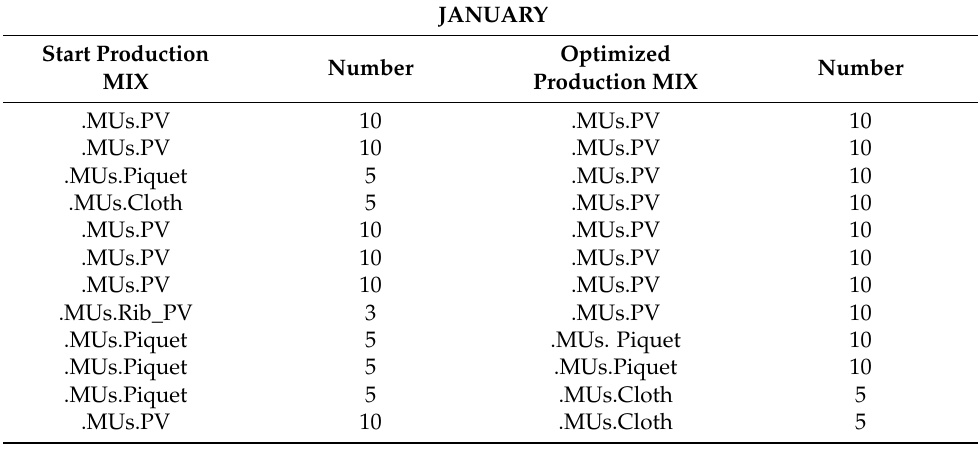
Table 6. Optimization results for